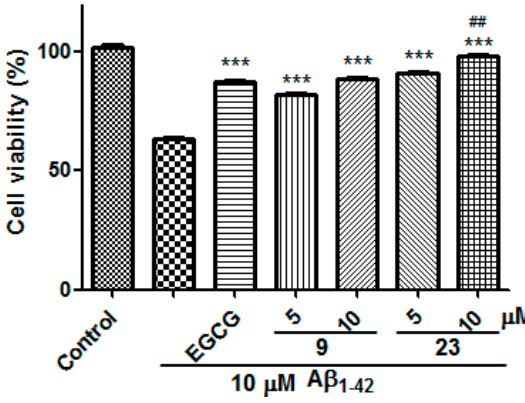
Figure 7. Protective effects of compounds 9 and 23 on A β 1-42 -induced toxicity in SH-SY5Y cells. Data are expressed as mean ± SD ( n = 3), *** p < 0.001 versus A β 1–42 treated only, and ## p < 0.01 versus positive control EGCG.